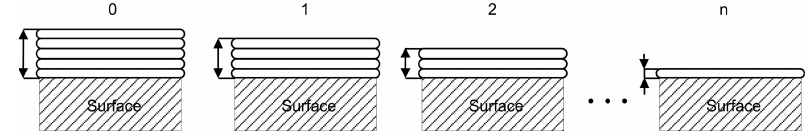
Figure 1. Corrosion process.